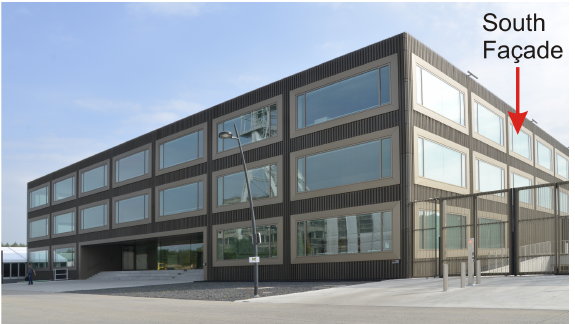
Figure 4. The EnergyVille building located in Genk, Belgium with 369.15 kW of peak PV installed